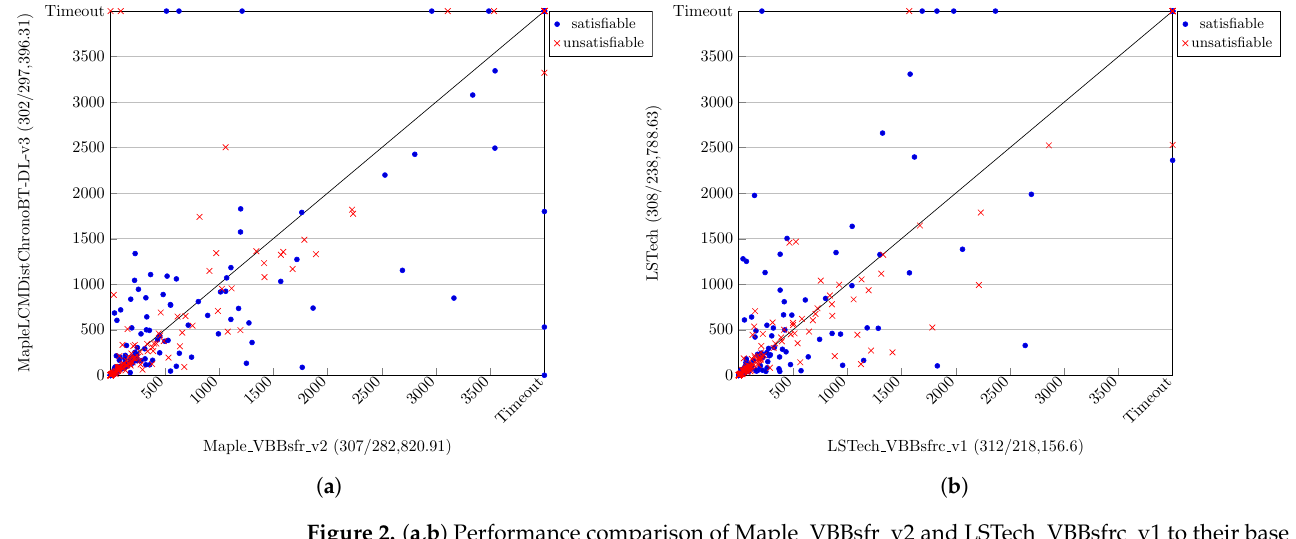
Figure 2. ( a , b ) Performance comparison of Maple_VBBsfr_v2 and LSTech_VBBsfrc_v1 to their base solvers. The results are on the whole 32 industrial benchmarks. For the x and y axes, the labels are of the form a(b/c), where a is the solver name, b is the total number of instances solved, and c is the PAR-2 score. In subfigure ( b ), for example, a point (1000, 1200) means that LSTech_VBBsfrc_v1 took 1000 s to solve the specified instance, whereas LSTech took 1200 s.